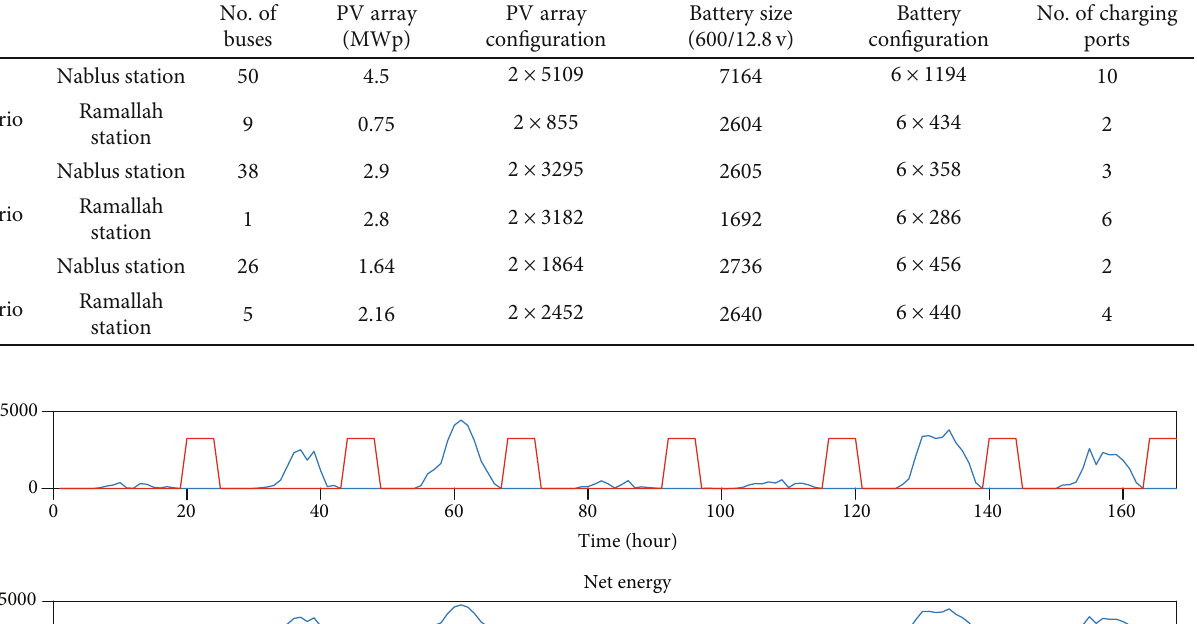
Table 2: Sizing results for all stations.